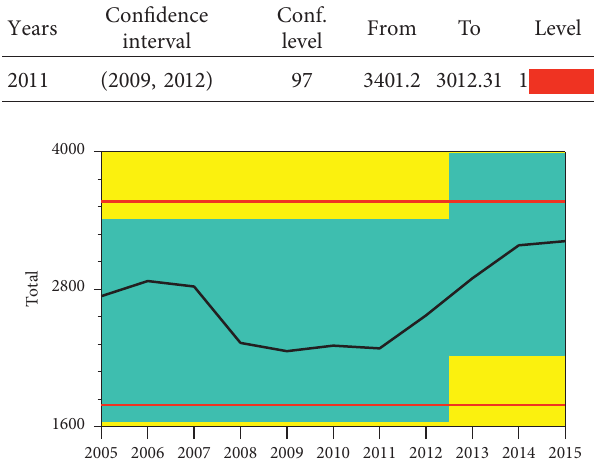
Table 5: Table of significant changes for murder in Gauteng.